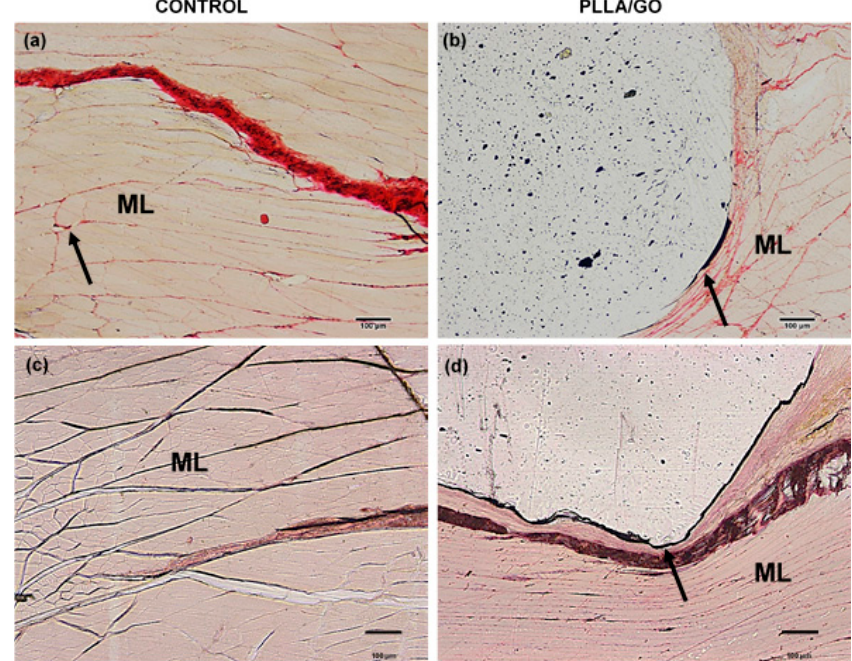
Figure 5. Gastrocnemius muscle histological section of control sample stained with Masson’s Trichrome and HE, highlighting the muscle layer (ML) and elastic fibers (arrow), bar: 100 µm ( a , c ), respectively; Gastrocnemius muscle with PLLA-GO histological section, stained with Masson’s Trichrome and HE, highlighting the muscle layer (ML) and the PLLA-GO insertion site indicated by (arrow), bar: 500 µm ( b , d ), respectively.